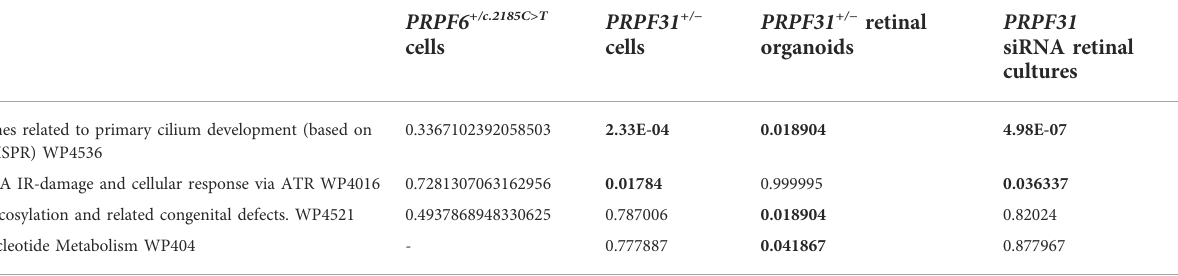
TABLE 2 FDR-adjusted p values from Wikipathway pathway enrichment analysis of differentially spliced exons in PRPF6 base edited cells, PRPF31 edited cells, PRPF31 +/ − patient-derived retinal organoids and PRPF31 siRNA-treated retinal cultures. Statistically signi fi cantly enriched pathways and their FDR-adjusted p values are highlighted in